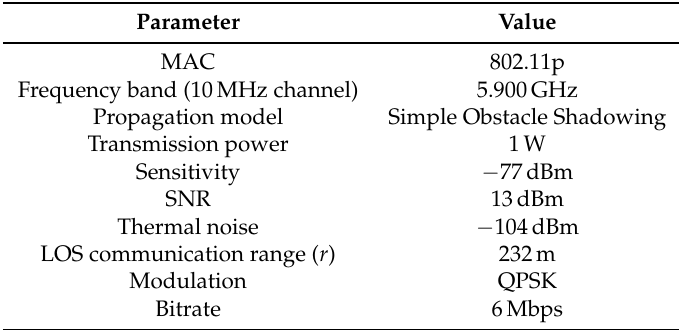
Table 2. Network parameters in the